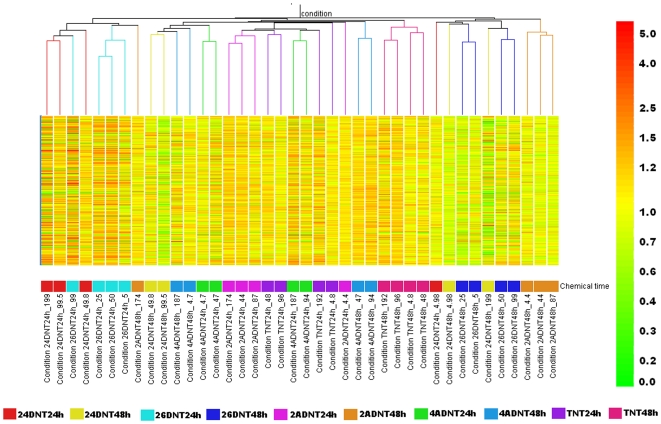
Hierarchical clustering of experimental conditions.Experimental conditions were based on averaging samples with the same dose treatments of a compound for 24 h or 48 h and total 40 experimental conditions were used for the clustering. Transcripts used for making these conditional trees were selected based on filtering on flags. Only a transcript that was presented in at least 50% samples was chosen for clustering. Pearson correlation algorithm with average linkage was conducted to calculate distances between conditions.